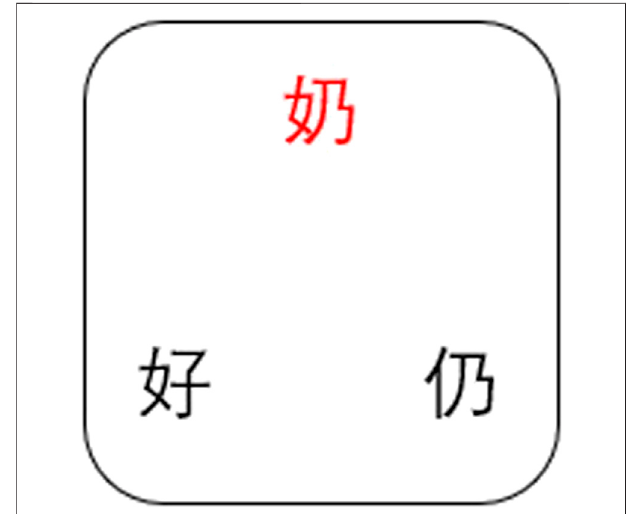
FIGURE 2 | An example of material for Experiment